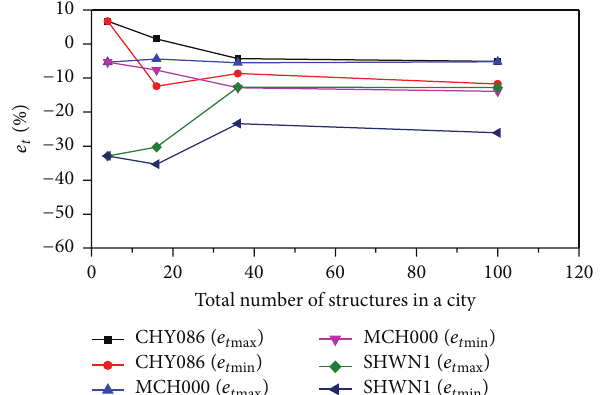
Figure 11: Interaction between structures in terms of influence coefficients 𝑒 𝑡 max and 𝑒 𝑡 min with respect to the number of structures in the urban area ( 𝐷 = 0.5 , 𝑆𝑋 ).